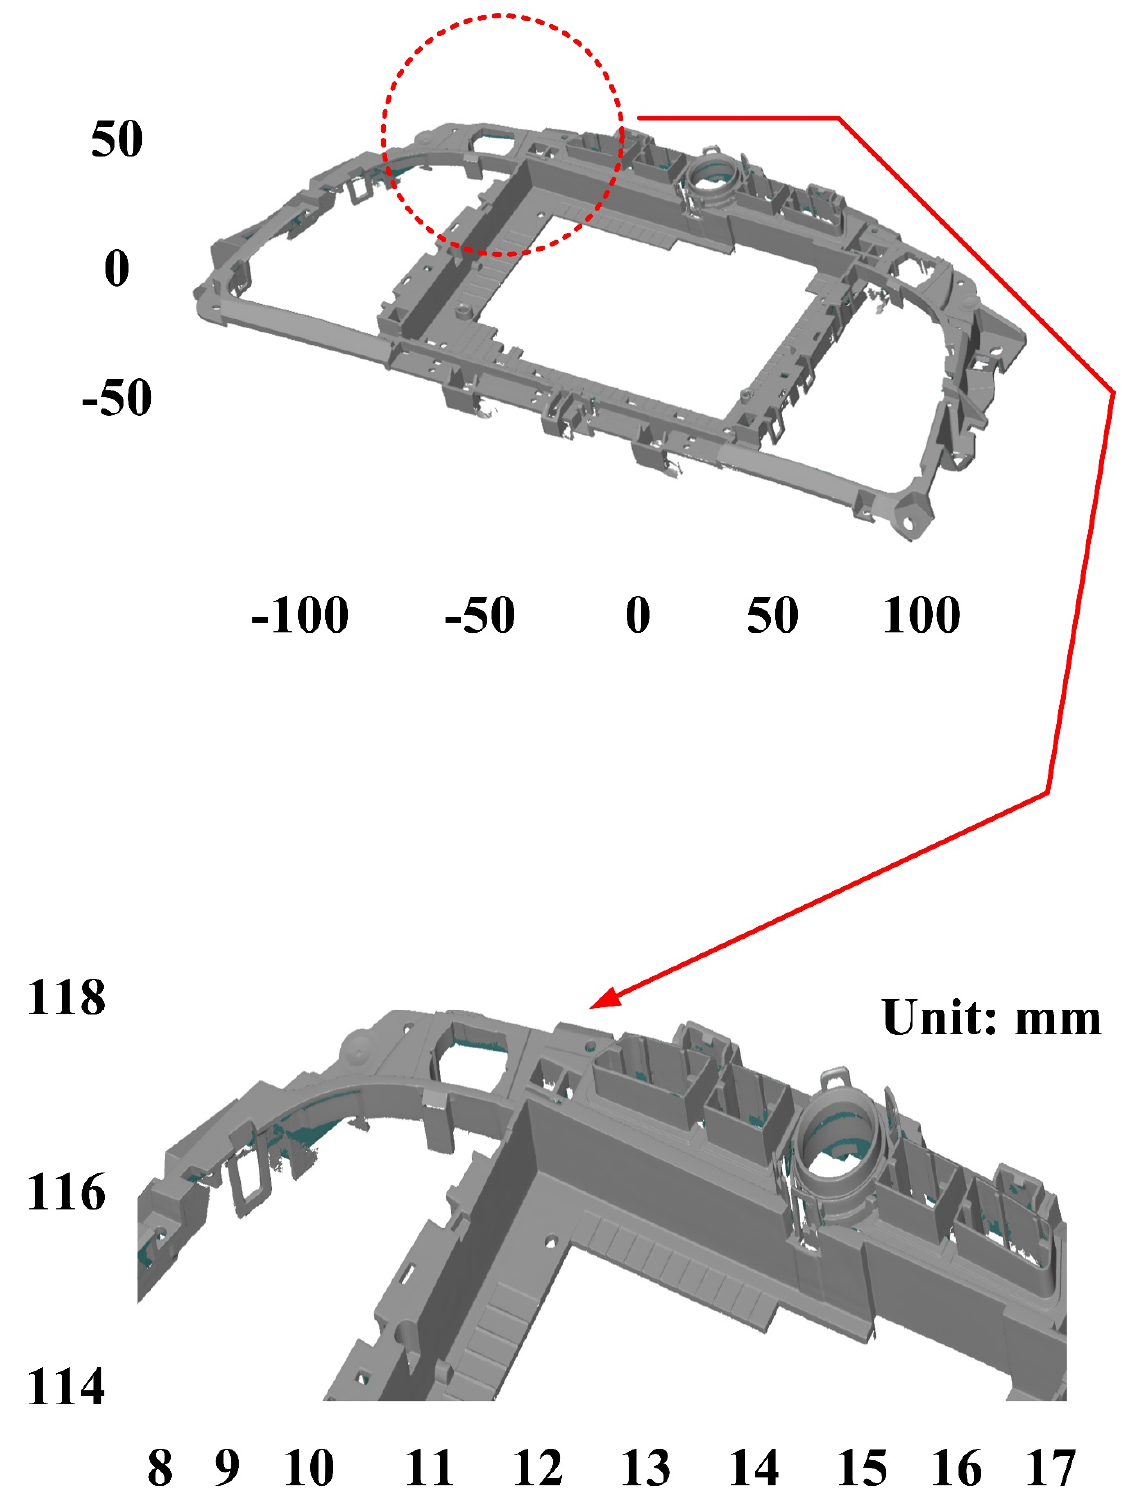
Figure 9. Measurement results of dark plastic part sprayed with mixture of TiO 2 powder and ethanol.